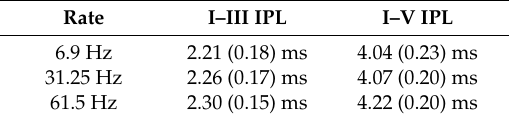
Table 4. Descriptive statistics of auditory brainstem response (ABR) Inter-Peak Latencies (IPLs). Means and standard deviations (parenthesis) or ABR inter-peak latencies for waves I–III and